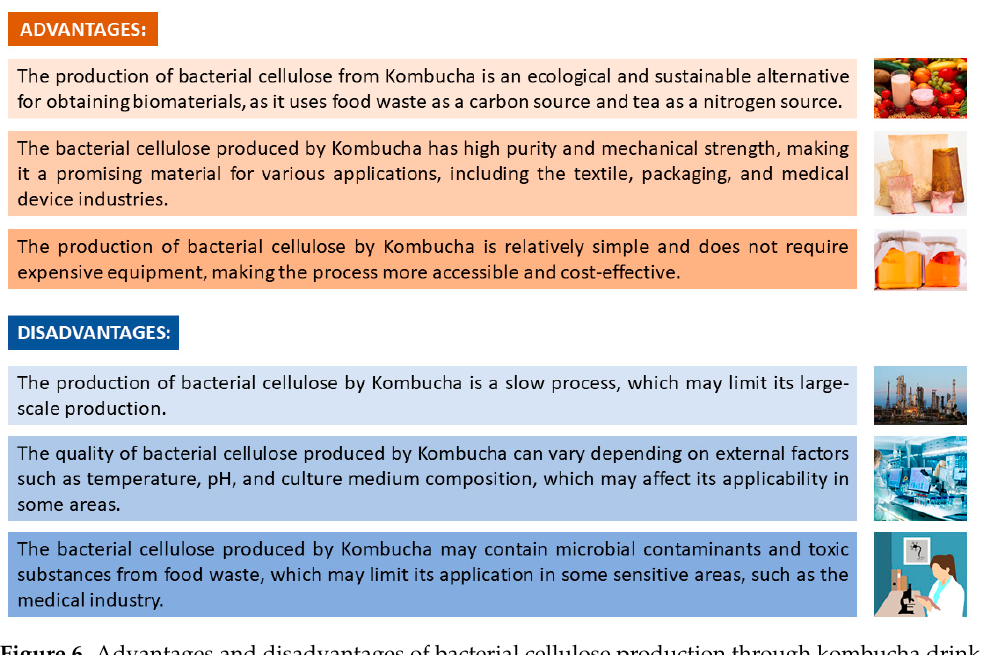
Figure 6. Advantages and disadvantages of bacterial cellulose production through kombucha drink. Source: authors,